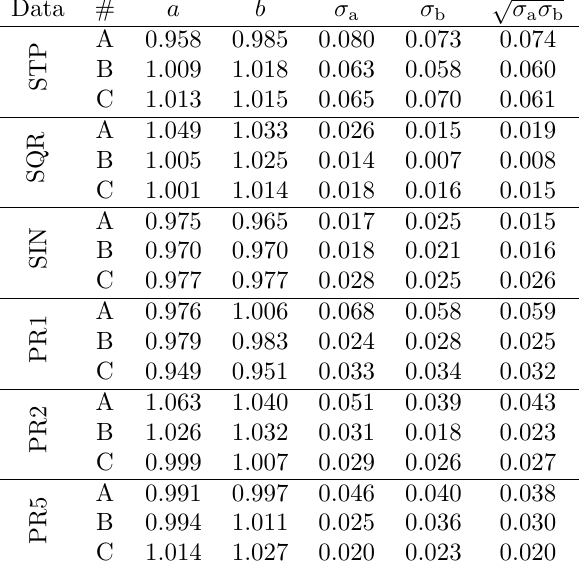
Table 2: Bootstrap results ( M = 200 iterations), Case A: Simple ( K = 10), Case B: Simple ( K = 5), Case C: Stationary ( p = 0 . 005).